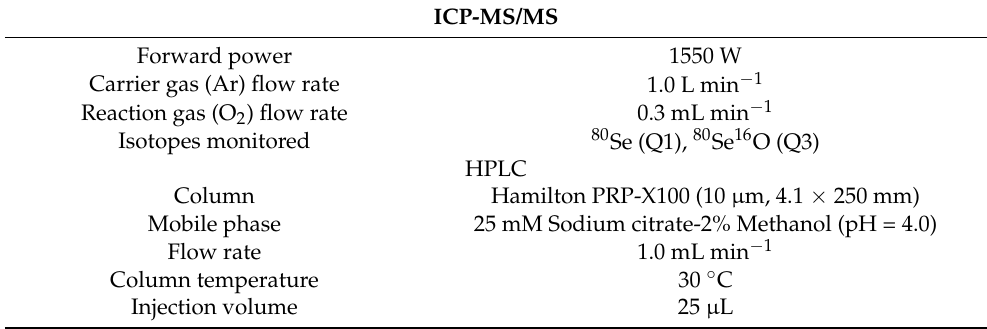
Table 1. Instrumental